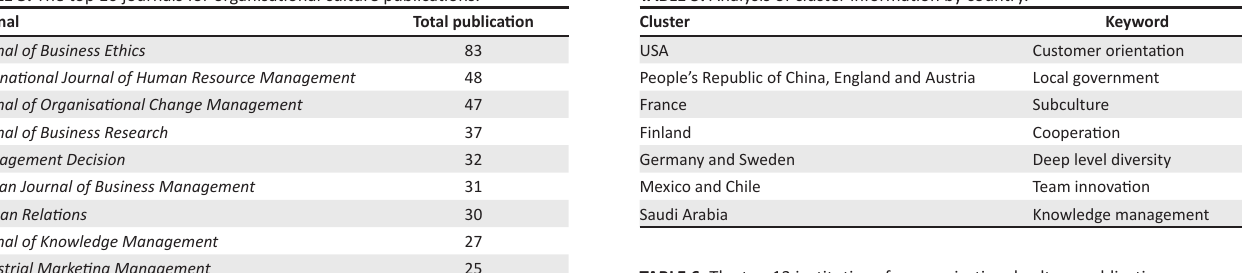
TABLE 6: The top 13 institutions for organisational culture publications.